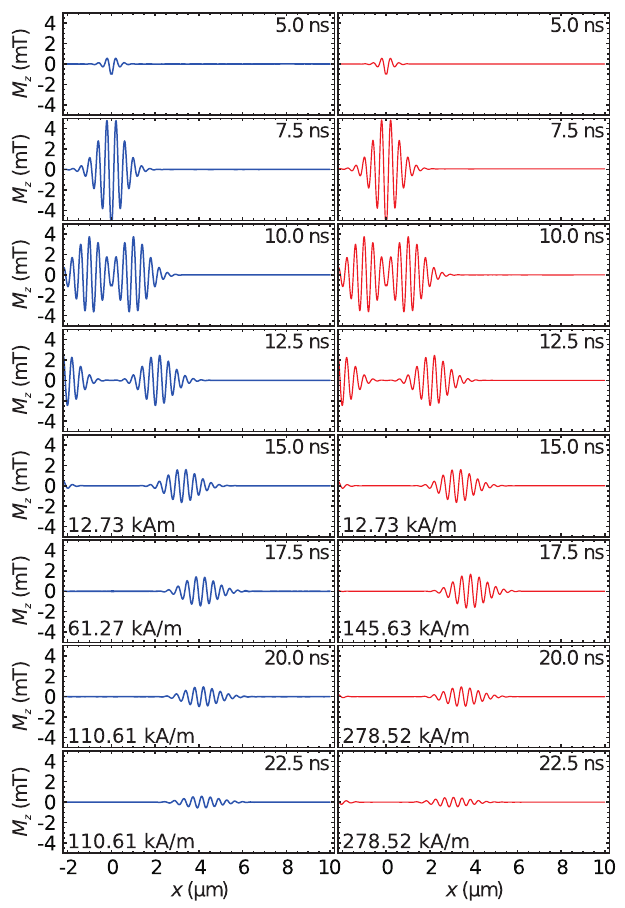
Figure 2. Plots of M z for the simulations of a stopped (left-hand side) and a reversed (right-hand side) Backward Volume